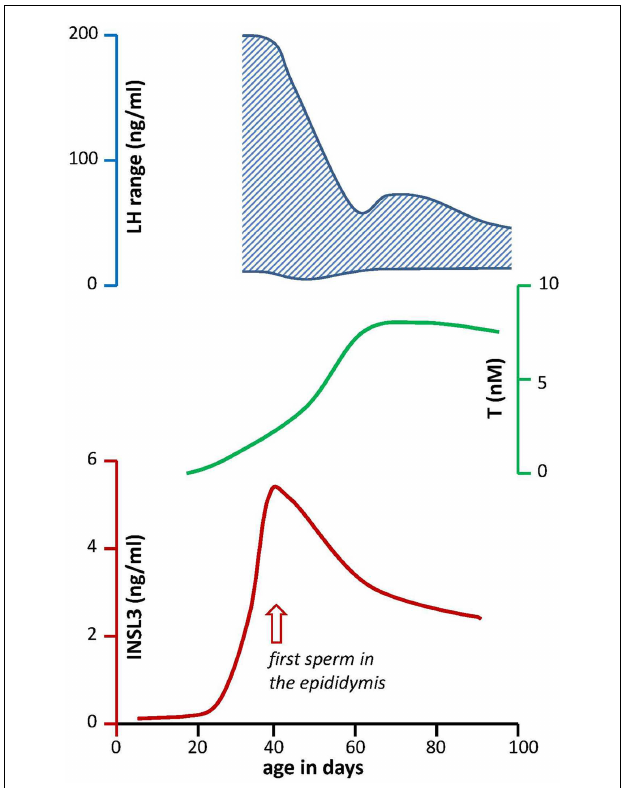
FIGURE 3 | Profiles through rat post-natal development for key circulating hormones of the HPG axis . LH (upper panel) is given as range to indicate the high degree of episodic secretion during early puberty, which is not represented in simple mean values (26).Testosterone (T; middle panel) concentrations are derived from Bartlett et al. (27) based on simple radioimmunassay.The profile for circulating INSL3 [lower panel; Ref. (10)] indicates the marked “overshoot” during early puberty, corresponding to the high LH variance (upper panel). Note that INSL3 values reduce to a stable lower concentration, concomitant with the asymptotic testosterone maximum, and the reduction in LH episodic